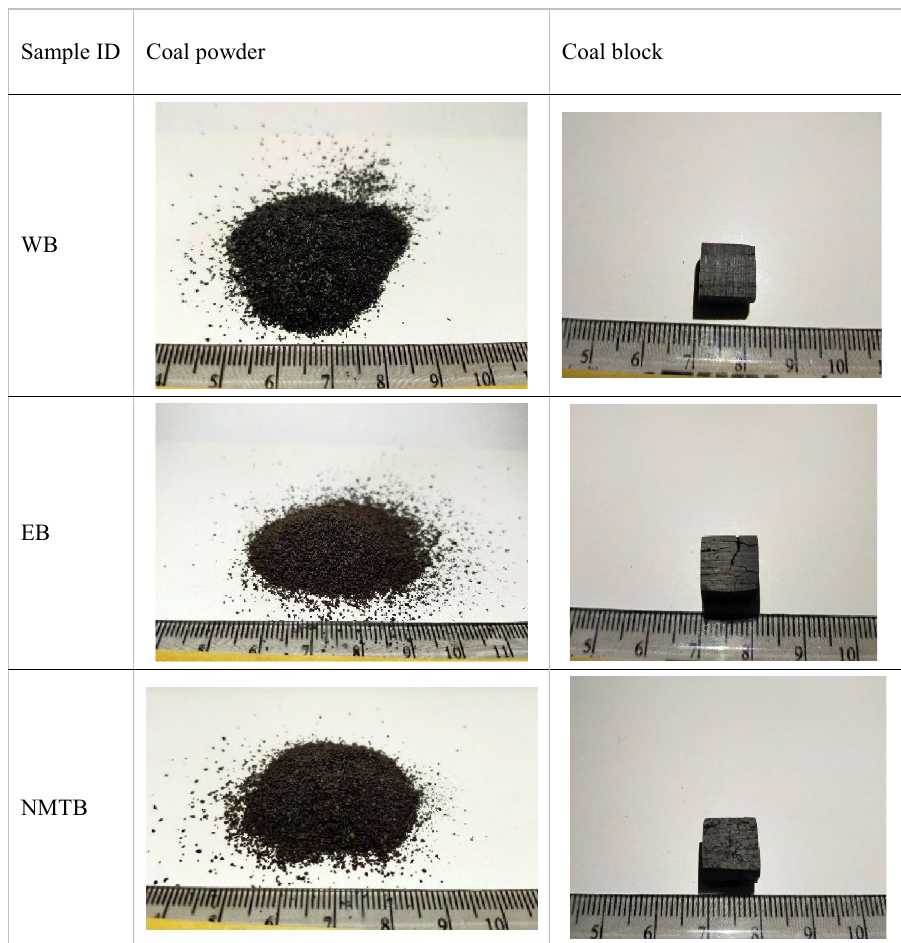
Table 1 Coal sample from all coal fields in different coal